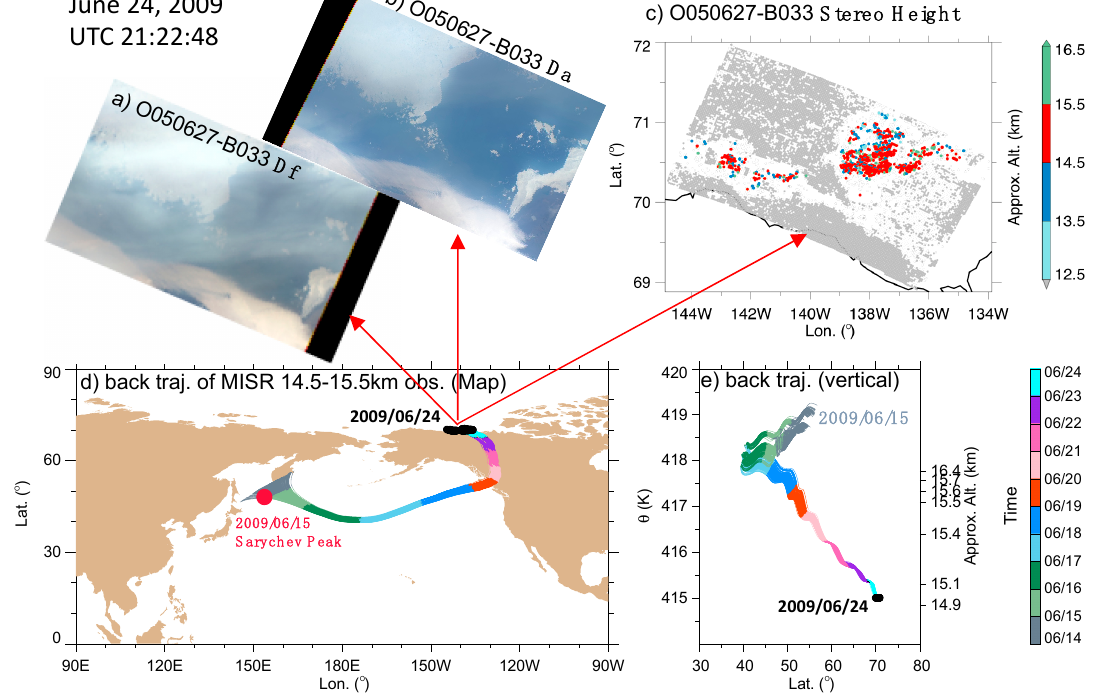
Figure 4. ( a ) MISR DF and ( b ) DA images over the Beaufort Sea at UTC 21:22:48 on 24 June 2009. Stratospheric aerosol layers make the DF image hazier than its symmetric DA image compared to the nadir view. ( c ) MINX stereo height retrievals, showing aerosol layer heights mostly at ~15 km. ( d ) MISR stratospheric aerosol plumes traced back to the Sarychev eruption on 15 June 2009 using dynamical fields from the ECMWF model (see text). ( e ) Descending air mass of the aerosol plumes during their transport from Sarychev to the Beaufort Sea, based on the ECMWF wind analysis.